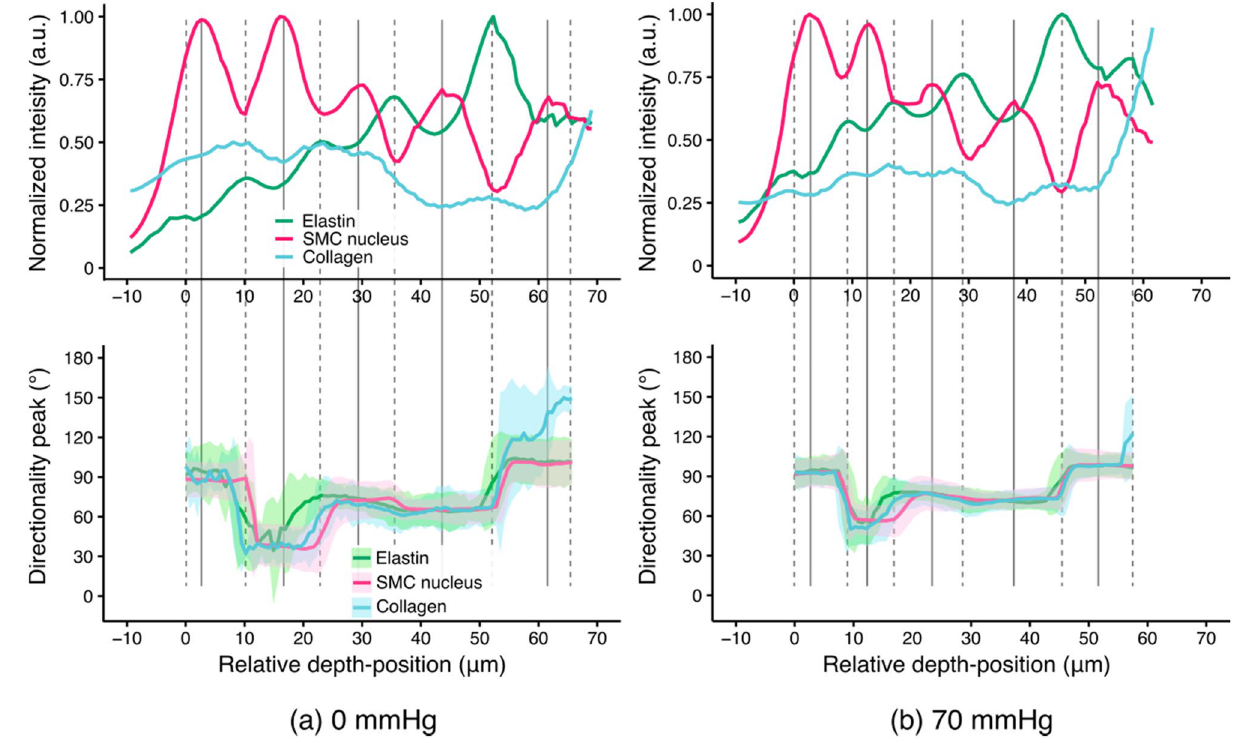
Figure 5. Representative signal intensity profiles of elastin autofluorescence, SMC nucleus staining, and collagen SHG (top), and the peak alignment angle of each component (bottom) obtained through the cleared aorta at an intraluminal pressure of ( a ) 0 mmHg and ( b ) 70 mmHg. Signal intensity was normalized to the maximum intensity of each respective component. The peak alignment angle (plotted with solid lines in the bottom) and the angle dispersion (equivalent to standard deviation, shown as bands) were determined using Directionality function in ImageJ/Fiji. The zero point of the horizontal axis corresponded to the peak in the first EL (EL1). Gray broken and solid lines drawn vertically indicate the depth-position of the local peaks of elastin autofluorescence and SMC nucleus fluorescence, respectively. The peak angle at 90° corresponds to the circumferential direction of the ( P < 0.001). At 100 mmHg, the trend was similar to that observed at 40 mmHg (Fig. 7b). The range of peak angles became smaller both in elastic fibers and SMC nuclei compared to the relationships at 40 mmHg. SMC nuclei alignment agreed well with the alignment of elastic fibers in the inner EL but poorly correlated with the align- ment of elastic fibers in the outer EL. It was also confirmed that the coefficient of the regression was significantly higher in the relationship between SML and the inner EL than that between SML and the outer EL ( P = 0.020).